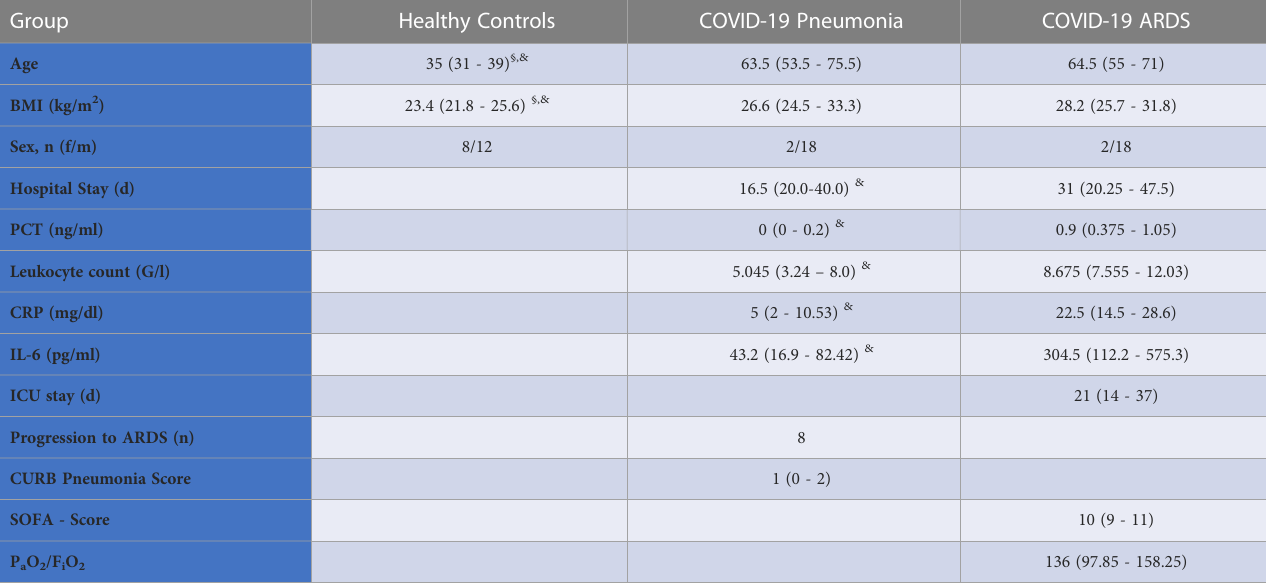
TABLE 1 Comparison of demographic and clinical data between study groups.